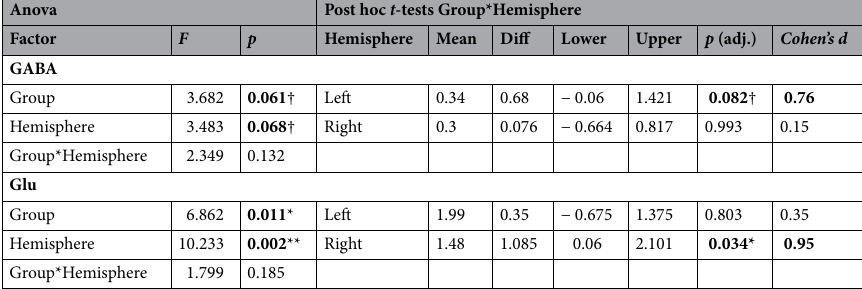
Table 2. ANOVA results for the models of GABA and Glu. Post hoc contrasts compare concentration levels between groups per hemisphere and are Tukey (HSD) adjusted. Confidence intervals are indicated by lower and upper bounds. Significant values are in bold.